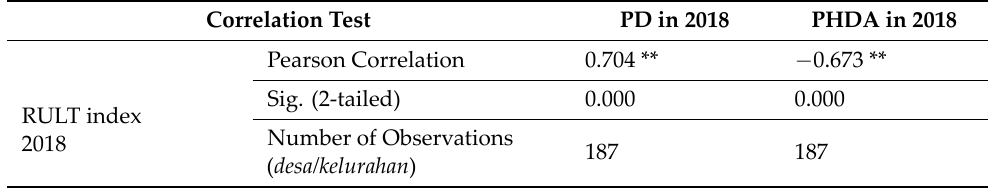
Table 3. PPM correlation test results.